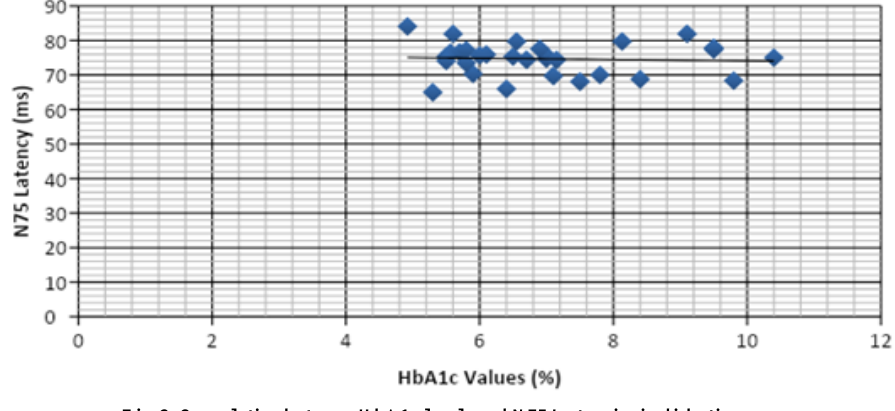
Fig. 2. Correlation between HbA1c levels and N75 Latencies in diabetics.